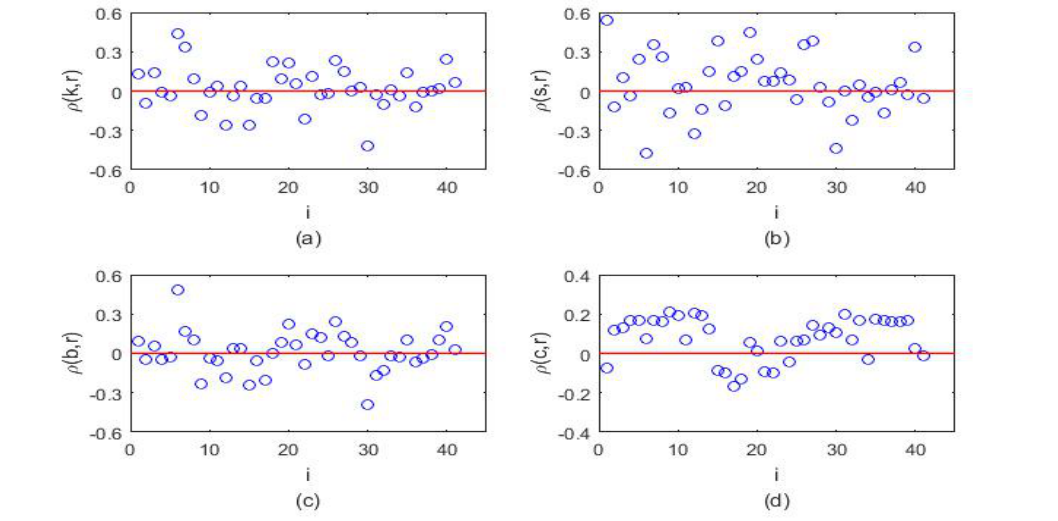
Figure 11. Pearson correlation coefficients between return and ( a ) node degree; ( b ) node strength; ( c ) betweenness centrality; ( d ) closeness centrality for each FX market.